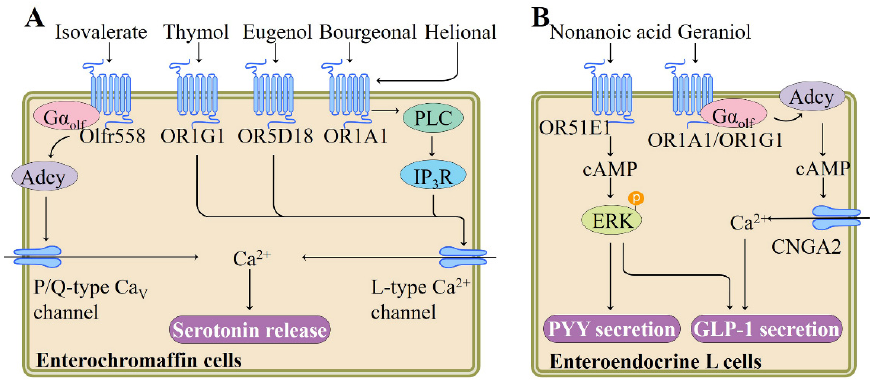
Figure 3. Summary of signaling pathways and functions regulated by ectopic ORs in enteroendocrine cells. ( A ) Activation of olfr558, OR1G1, OR5D18, or OR1A1 enhances the release of serotonin from enterochromaffin cells, adapted from [62,63], published by LIPPINCOTT WILLIAMS & WILKINS, 2013 and Cell Press, 2007. ( B ) Regulation of GLP-1 and PYY secretion from enteroendocrine L cells through OR51E1, OR1A1, or OR1G1, adapted from [64], published by Philadelphia, PA: W.B. Saun- ders, 2017. Adcy, adenylyl cyclase; CNGA2, cyclic nucleotide gated channel subunit alpha 2; cAMP, cyclic adenosine monophosphate; ERK, extracellular signal-regulated kinase; IP 3 R, inositol-1,4,5- trisphosphate (IP 3 ) receptor; G α olf , olfactory G protein alpha subunit; GLP-1, glucagon-like peptide 1; PLC, Gq-phospholipase C; PYY, peptide